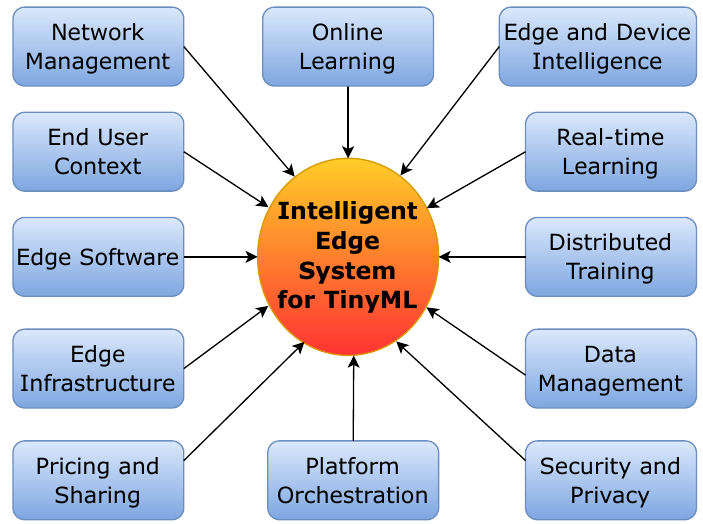
Figure 18. Basics key enablers of